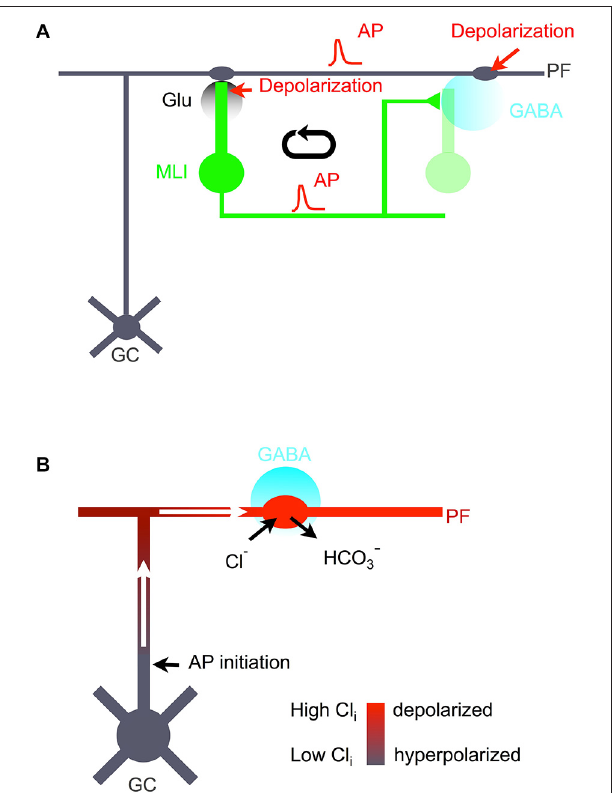
FIGURE 9 | Excitatory GABA loop. (A) Cellular mechanism and functional role of excitatory GABA action in the cerebellar molecular layer. Following firing of granule cells (GC) and associated PFs (gray), postsynaptic MLIs (green) are depolarized, leading to AP firing and to increased Ca i levels both in somata and in synaptic terminals. Synaptic terminal excitation produces GABA release (cyan). While released GABA affects postsynaptic cells (light green), spillover GABA diffuses to PF varicosities. These varicosities bear GABA A Rs and are depolarized by spillover GABA. This enhances AP firing in PFs, thus closing the loop. (B) Proposed model of GC excitation following activation of PF GABA A Rs. In PF varicosities, because of a favorable surface to volume ratio, activation of GABA A Rs leads to Cl − entry, bicarbonate exit, and membrane depolarization (depicted in red). No AP is initiated at the site of GABA action because of shunting inhibition. However, the depolarized varicosity acts as a current sink, drawing depolarizing current flow along the axon cable (white arrows). This leads to AP initiation at sites where GABA A Rs are not activated, e.g., at the GC axon initial